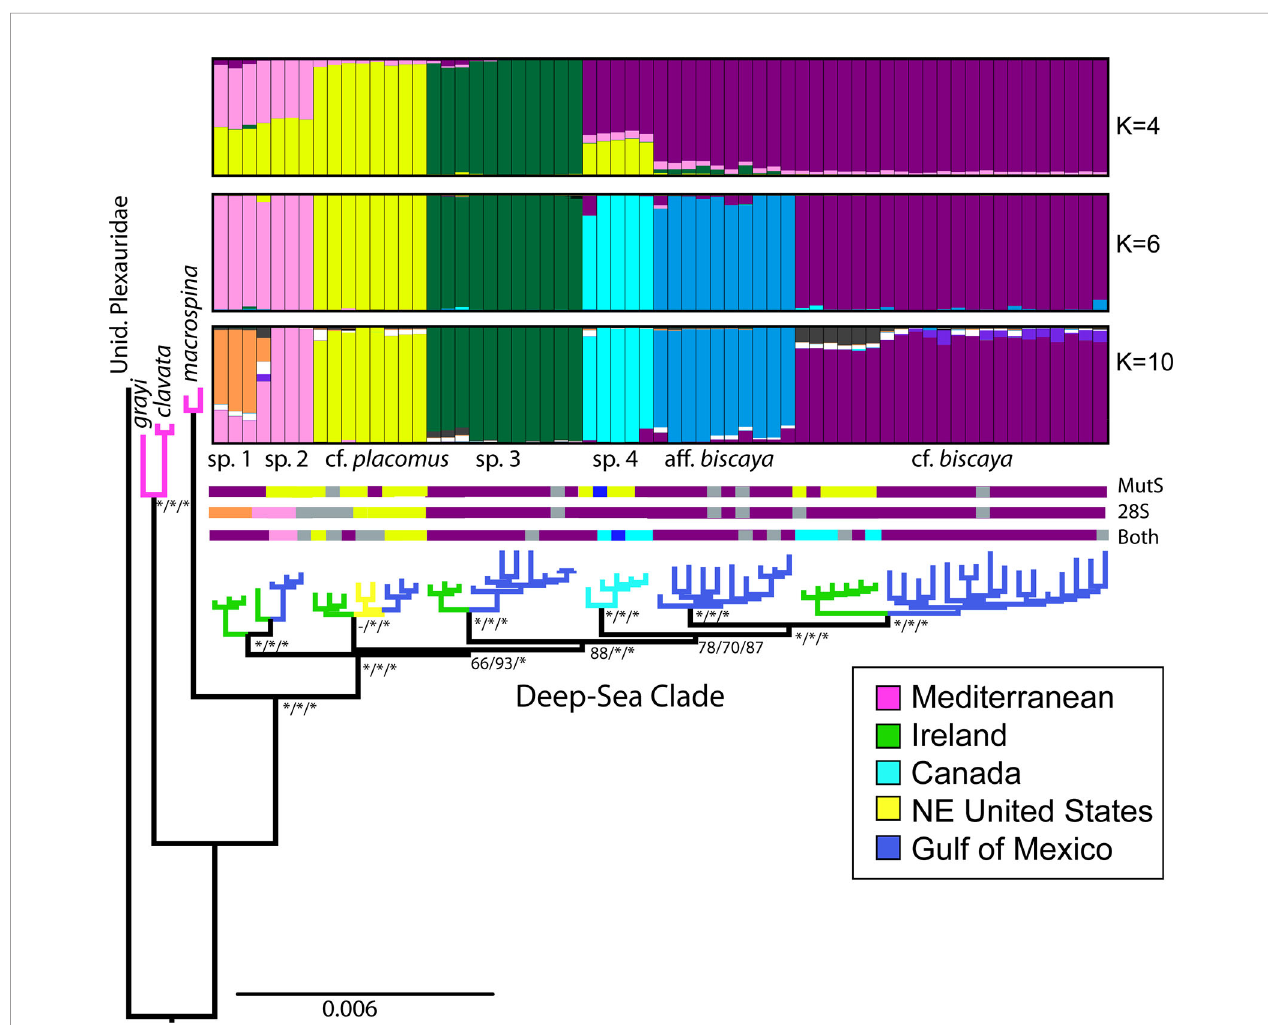
FIGURE 2 | Maximum likelihood phylogeny from concatenated RAD-Seq data (2,861 loci, 249,438 SNPs) generated by IQTree. STRUCTURE membership of probability graphs (K=4, 6 and 10) for the deep-sea clade (3,821 unlinked SNPs) included. Molecular operational taxonomic units (MOTUs) assigned by Mothur analysis (color-coded, grey=unavailable) for mtMutS, 28S, and ‘ Both ’ genes. Branches are color-coded to sampling location. Node labels represent support values (*>95% support) from RAxML rapid bootstrapping/SH-like approximate likelihood ratio test/IQTree ultrafast bootstrapping for each putative species (see supplemental data for all support values in .tre fi le). The phylogeny is rooted to an unidenti fi ed species of